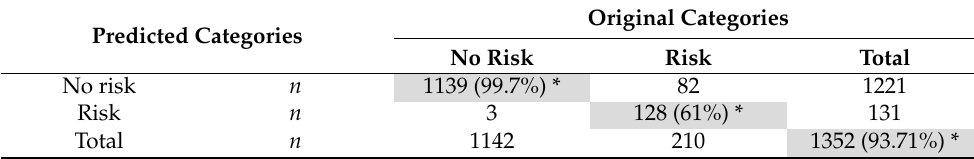
Table 6. Concordance Index between original and predicted Downton scale